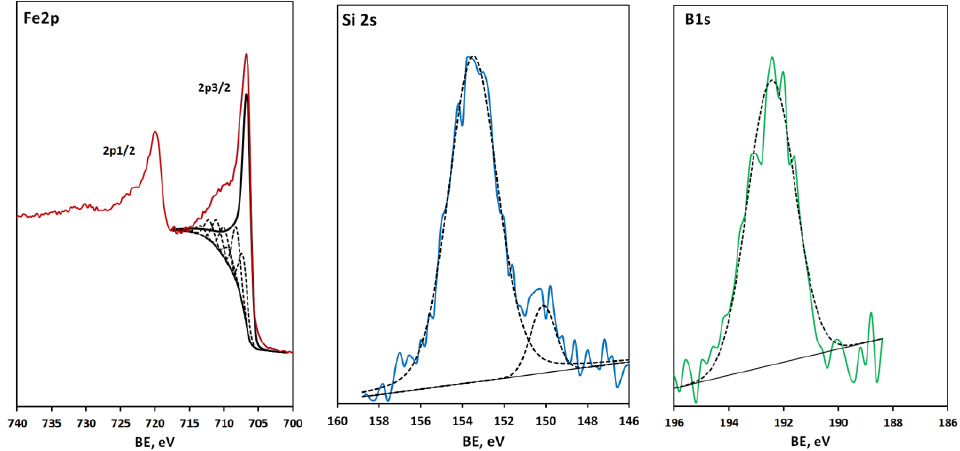
Figure 5. Fe 2p, Si 2s and B 1s spectra of a metglas-on-silicon sample, produced at the second stage of the technology improvement. Experimental spectra (solid colour lines) were fitted using the bands which are depicted by black dashed lines, save the band at 706.7 eV assigned to metallic iron, highlighted with a solid black line.